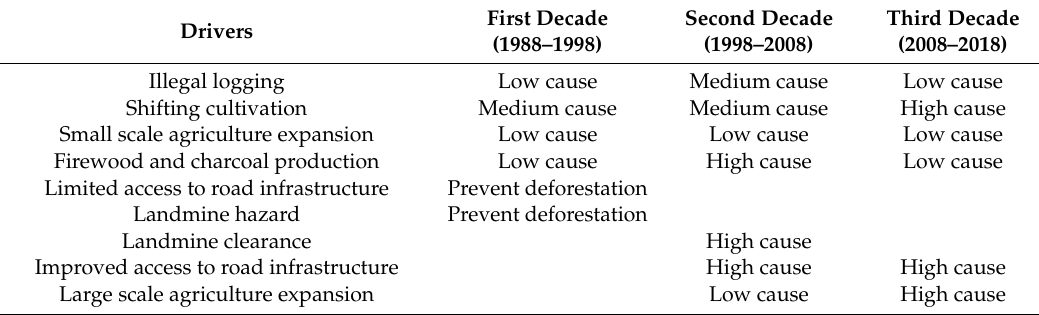
Table 3. Drivers of deforestation for the last three decades at the upper of Siem Reap